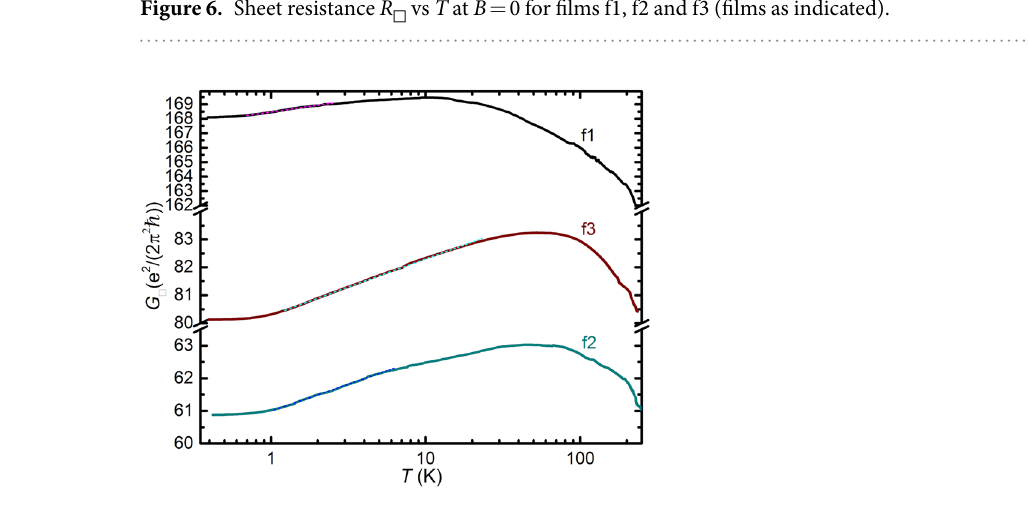
Figure 6. Sheet resistance R